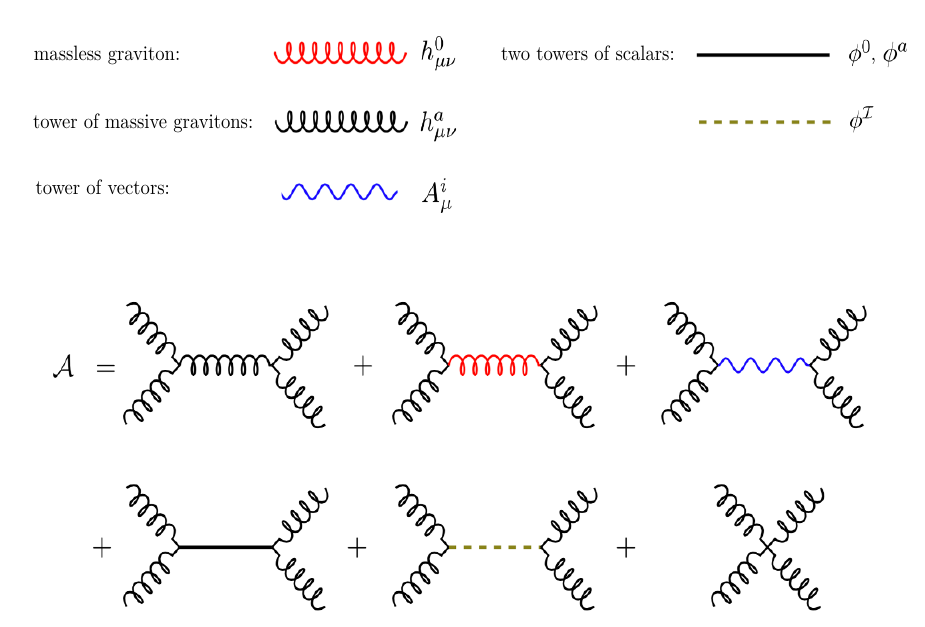
Figure 1 . The spectrum of GR KK reduced on a general closed Ricci-(cid:13)at manifold and a schematic representation of the four-point tree-level massive graviton